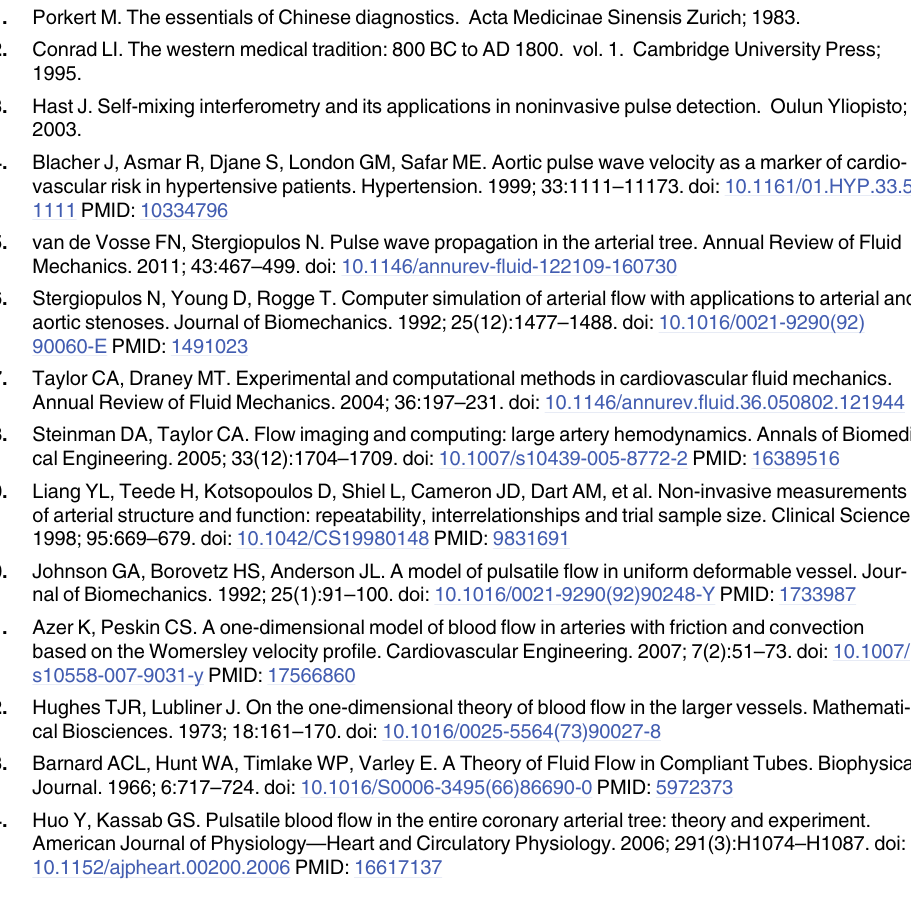
in the x-axis k